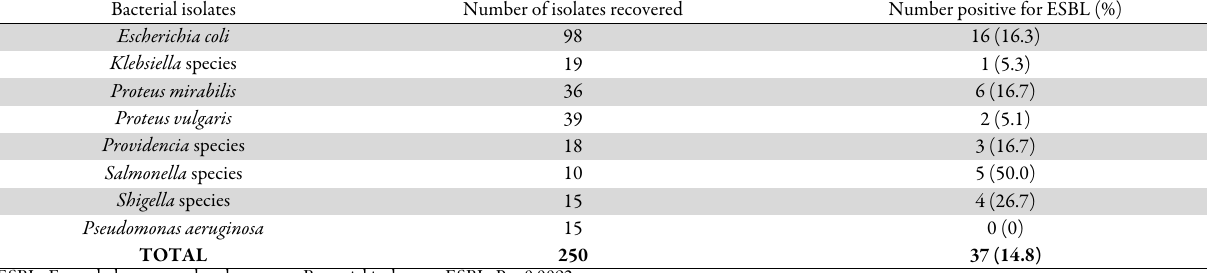
Table 2. Distribution of ESBL among Gram negative bacterial isolates recovered from cattle feces Bacterial isolates Number of isolates recovered Number positive for ESBL (%) Escherichia coli 98 16 (16.3) Klebsiella species